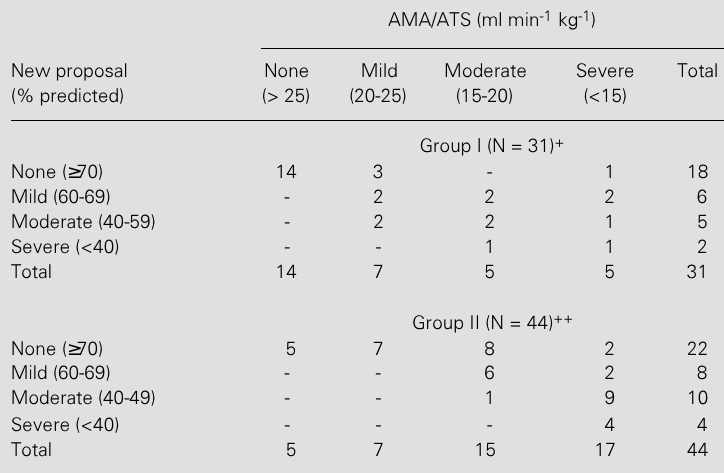
Figure 1 - Receiver operating characteristics (ROC) curves of the two classifications, using the VO 2 at the anaerobic threshold (VO 2 AT) as the (cid:147)gold standard(cid:148) for aerobic dysfunction. Open squares, Cutoffs of normality for VO 2 max regarding to the two classifications; AUC = area un- der the ROC curve.